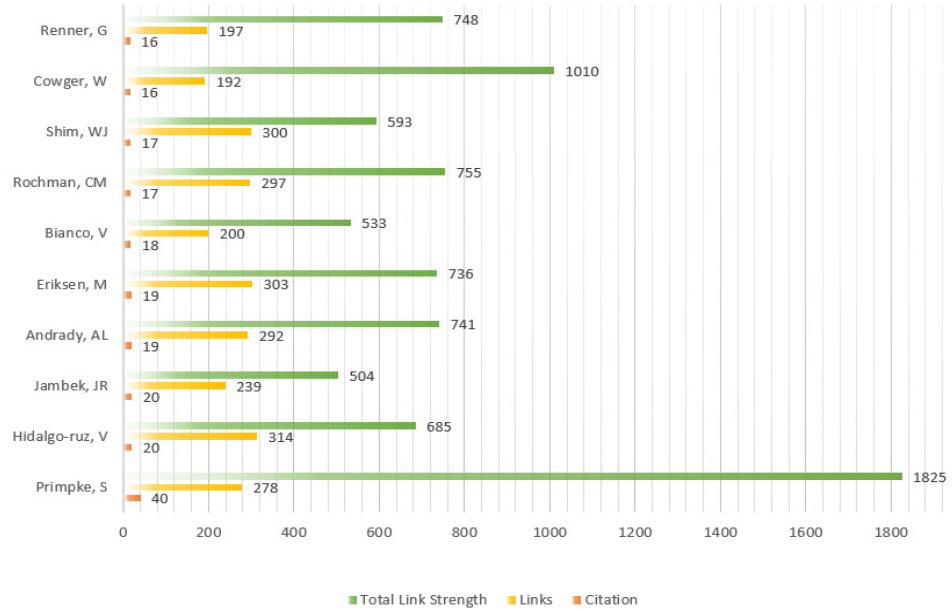
Figure 17. The most co-citation